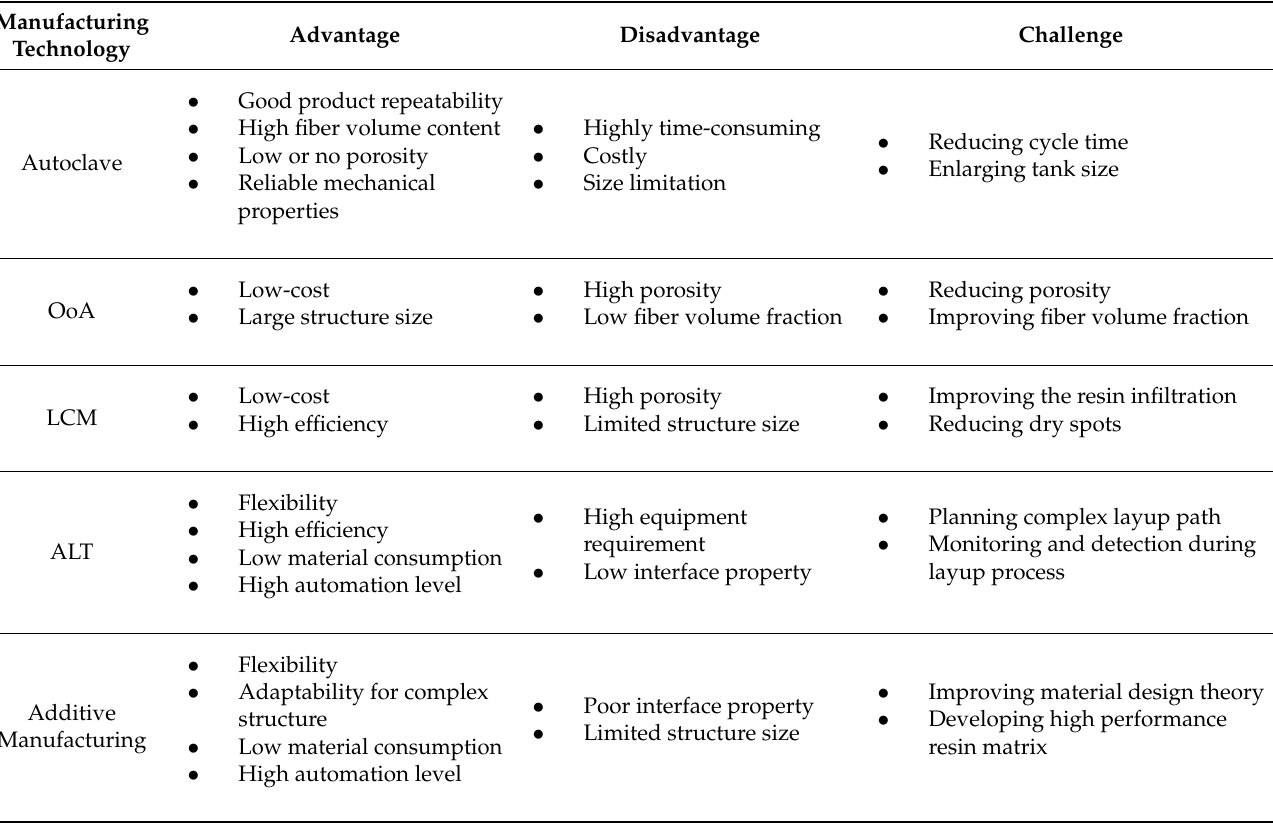
Table 3. Comparison of main manufacturing technologies for fiber-reinforced composite